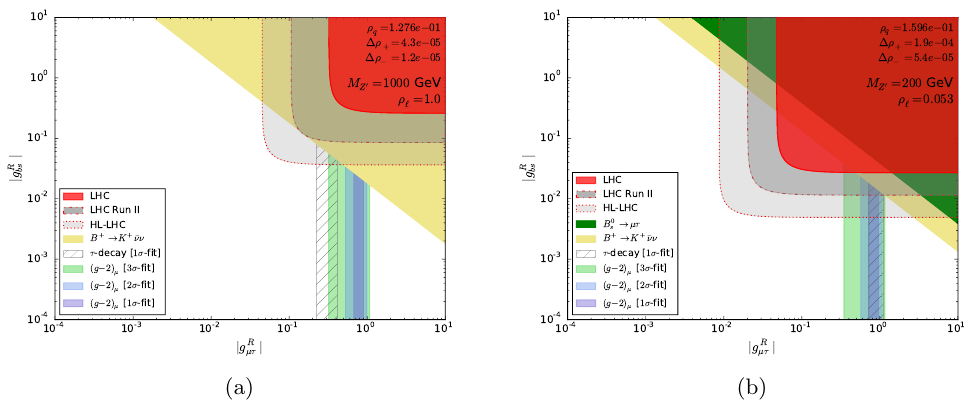
Figure 18 . The left (right) panel shows the g R (cid:0) g R plane for a Z 0 boson with M Z 0 = 1000 (200) (cid:22)(cid:28) bs GeV and a lepton coupling ratio of (cid:26) ‘ = 1.0 (0.053). The red area indicates the limit from the p ATLAS analysis of the process pp ! (cid:22)(cid:28) at s = 8 TeV. The red dash-dotted and dashed lines are projections to the LHC Run II and HL-LHC. The green area represents the excluded region from the leptonic meson decay B 0 ! (cid:22)(cid:28) . The yellow area is the limit from meson decay into neutrinos s B + ! K + (cid:22) (cid:23)(cid:23) . The purple, blue and light green bands are the preferred 1, 2 and 3 (cid:27) bands from (cid:1) a (cid:22) . The black and white hatched area depicts the preferred 1 (cid:27) region of the observed deviation (cid:1) R = R =R SM (cid:0) 1. (cid:22)=e (cid:22)=e (cid:22)=e